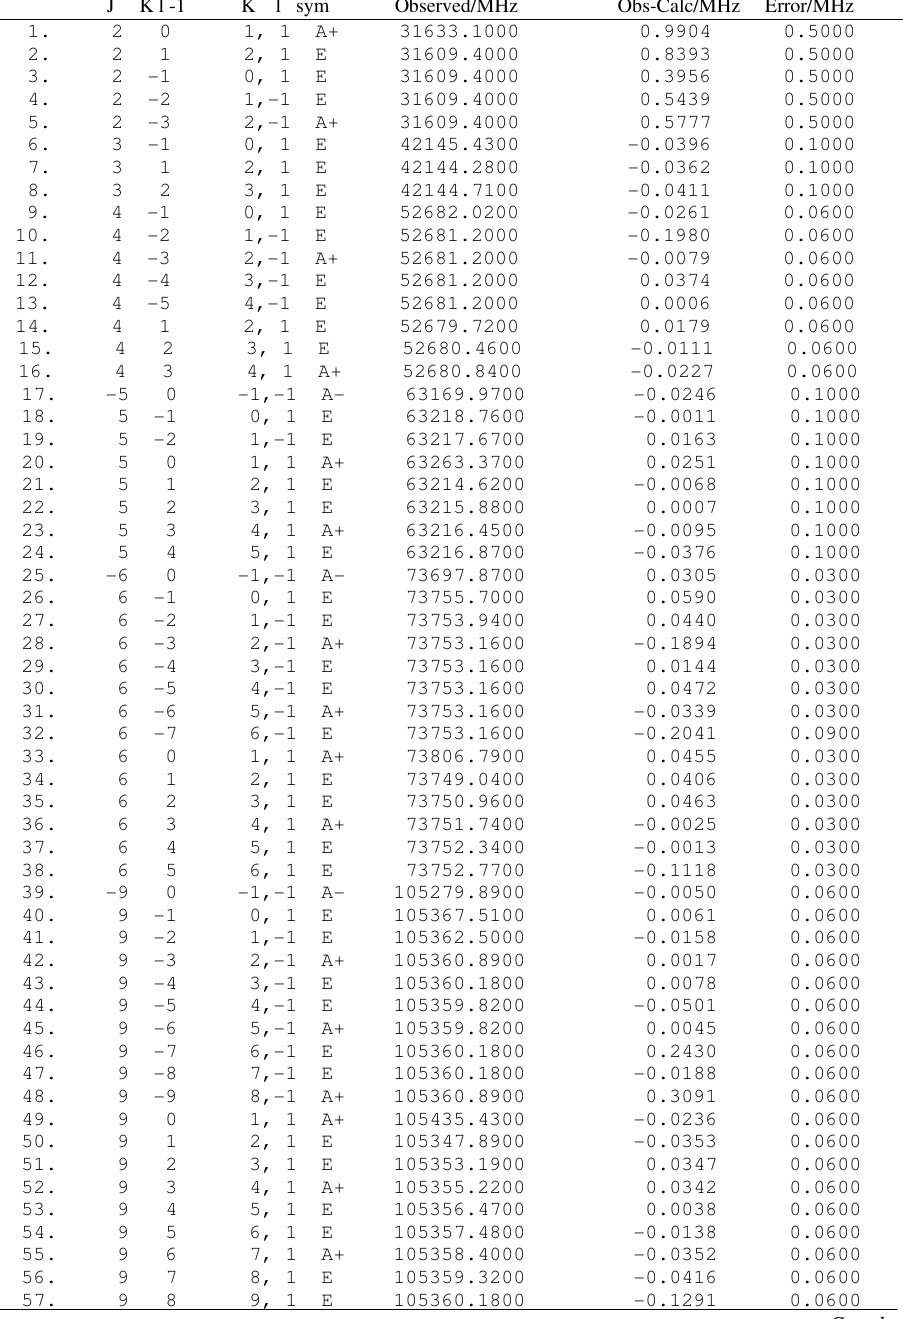
O) in v (E) = 1 2 3 1